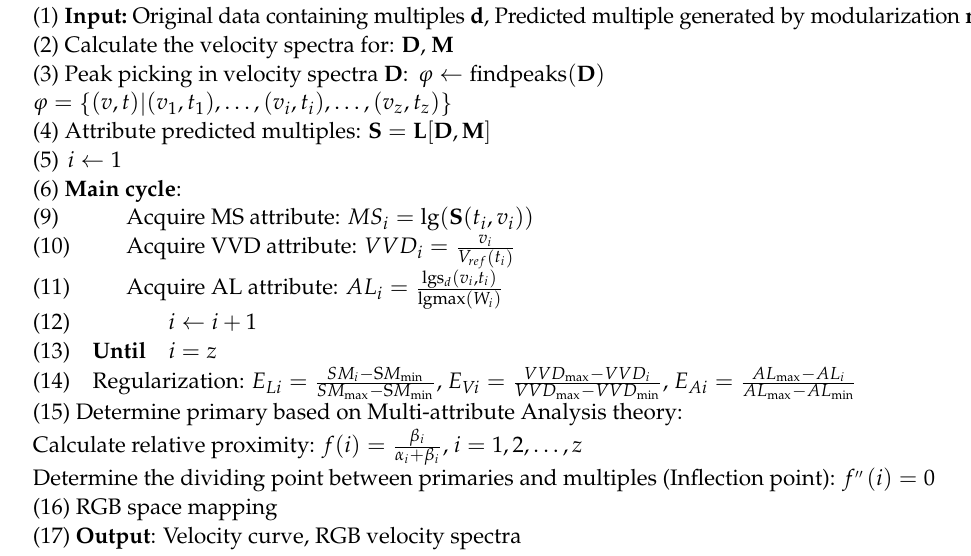
Algorithm 1: Multiple Independent Automatic Velocity Analysis